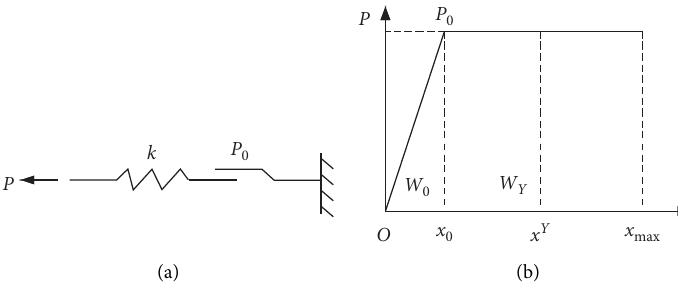
Figure 9: Constitutive and energy model of the anchor cable. (a) Constitutive relation. (b) Energy model.